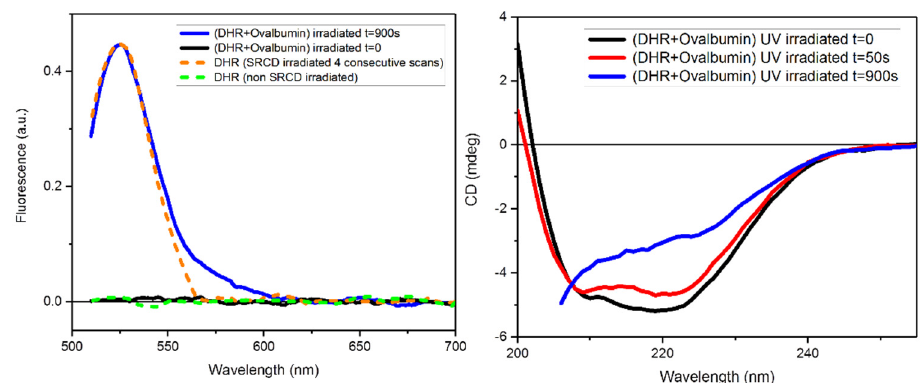
Figure 6. Characterization of the interaction between ovalbumin and DHR-123. ( Left ) Fluorescence emission spectra of DHR-123 (0.288 µM) in the presence of ovalbumin (0.009 mg/mL) irradiated with UV-C lamp in 20 mM PBS buffer, pH 7.4. Fluorescence spectra were recorded at 25 °C using a Chirascan Plus spectrometer, excitation at 505 nm, integration time 1 s, 1.0 cm cell (3000 µL), monochromator slit widths 4 nm. ( Right ) With the same set up but in CD mode the far-UV CD spectra of ovalbumin (0.009 mg/mL) in 20 mM PBS buffer, pH 7.4, were measured in the presence of DHR-123 (0.288 µM) both irradiated with a UV-lamp (t = 0 (black), t = 50s (red), and t = 900s (blue)). CD spectra were recorded at 25 °C using a Chirascan Plus spectrometer, integration time 1 s, 1.0 cm cell (3000 µL), monochromator slit widths 1.0 nm.